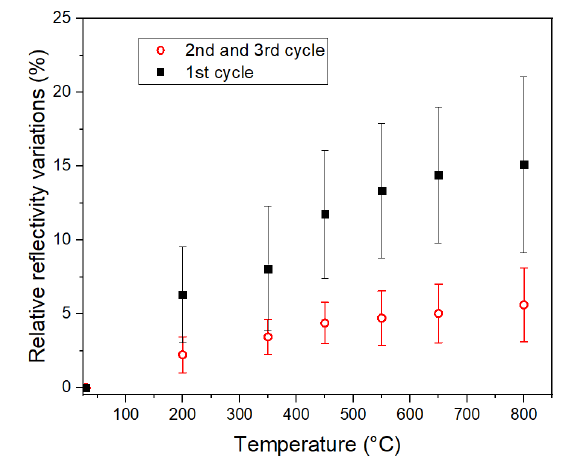
Figure 3. Relative reflectivity variation (with respect to the RT curve) at 840 nm as a function of temperature, during the first annealing (black squares) and the second and third ones (averaged, open red circles). Each point was obtained by averaging over the five samples, the error bar being the standard